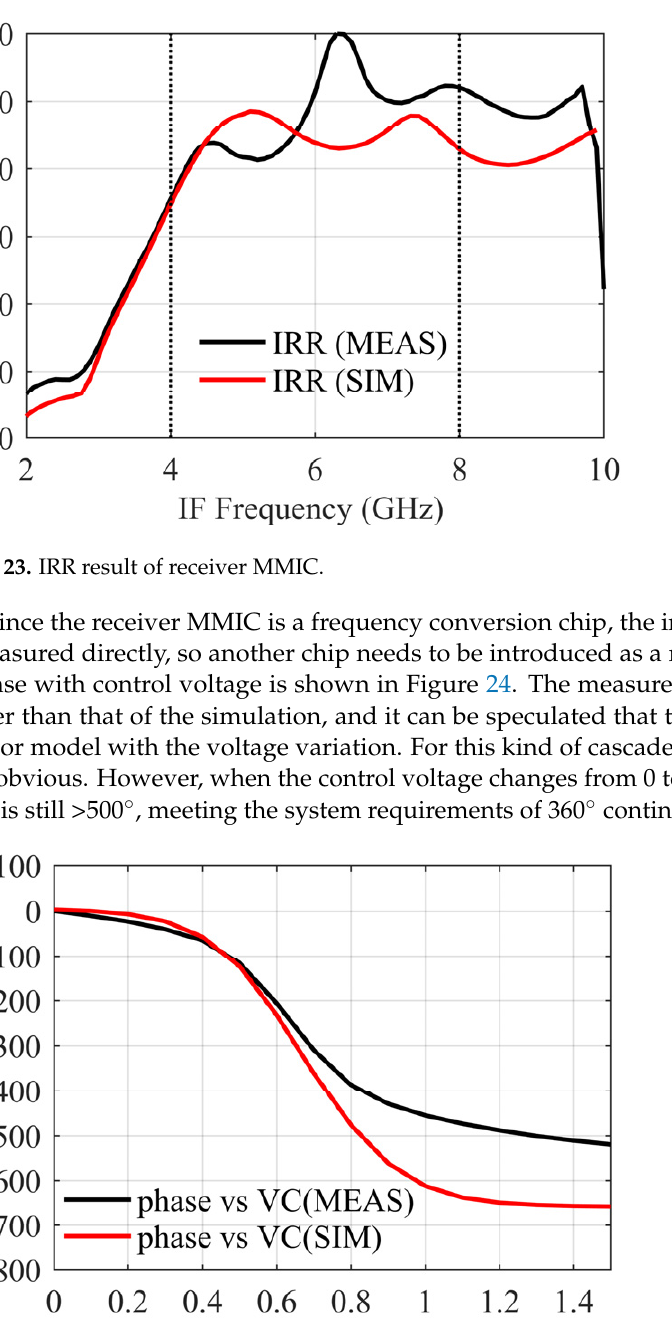
Figure 24. Results of phase shift vs. control voltage.